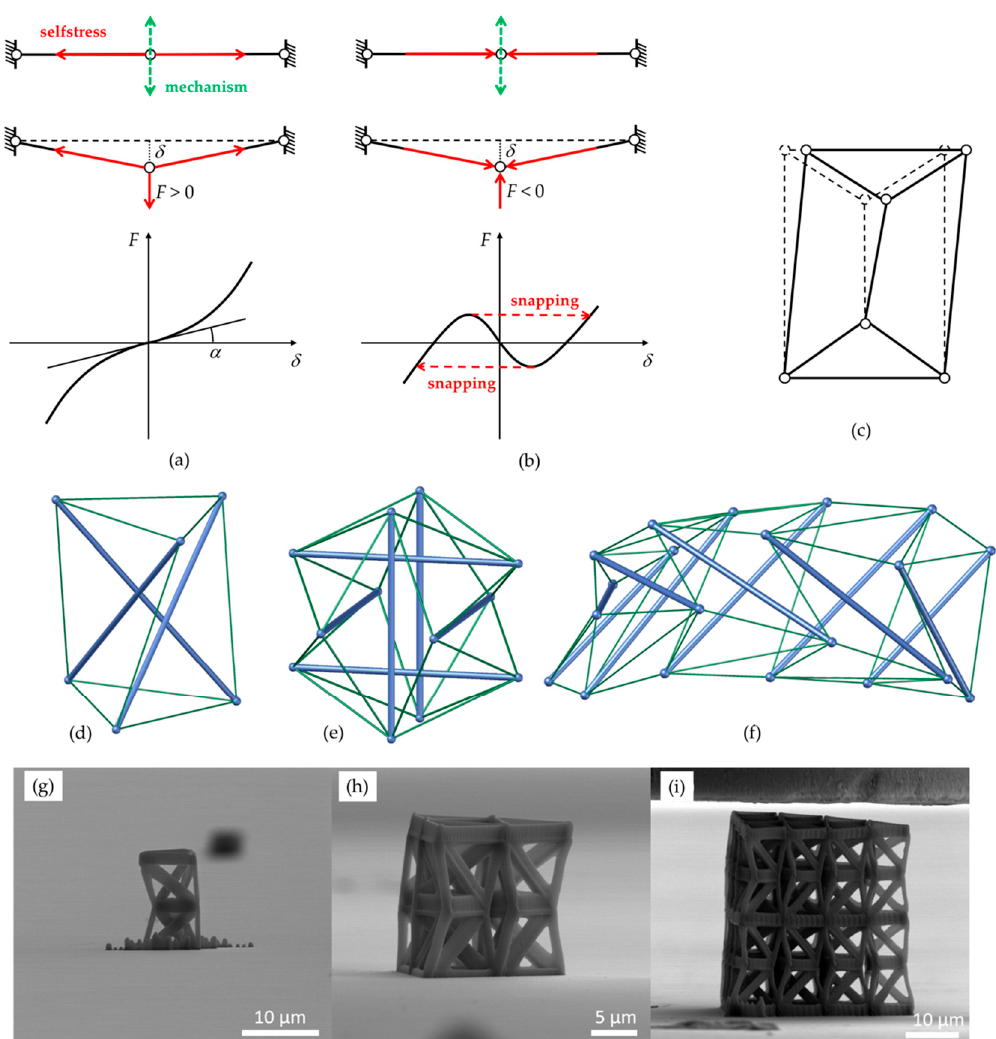
Figure 1. Illustration of the analyzed behaviors and fabricated structures . ( a ) Selfstress and mechanism in the prestress-stable two-element system (top). Deformed configuration under a vertical load and corresponding response (center and bottom). ( b ) Corresponding bistable system and bistable snapping response under the same vertical load. ( c , d , e , f ) Examples of prestress-stable systems with one seflstress state and one mechanism: ( c ) A two-dimensional system displaced along its mechanism; ( d ) triangular tensegrity prism; ( e ) expanded octahedron or tensegrity icosahedron; ( f ) an irregular x - tower. Fabricated geometries of structures: ( g ) individual unit cells, ( h ) arrays of three unit cells in one layer, ( i ) arrays of two layers with ten unit cells at each layer .